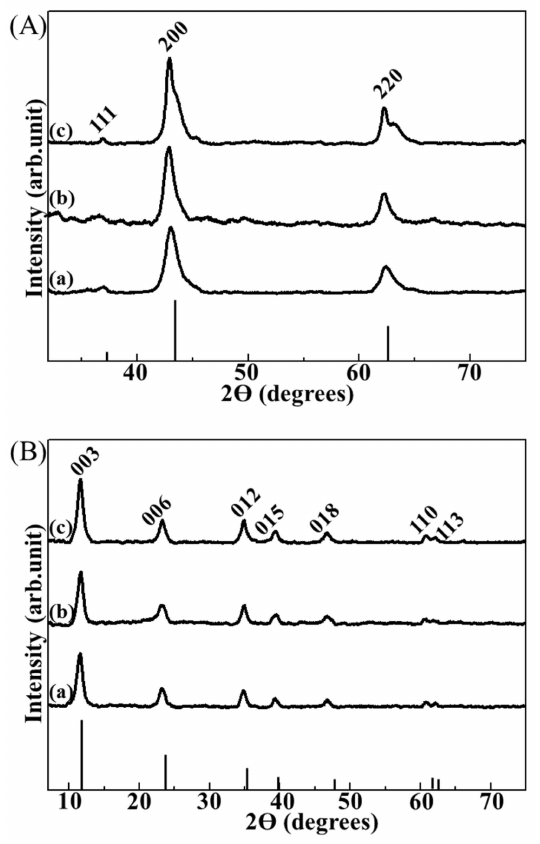
Figure 2. X-ray diffraction (XRD) patterns of ( A ) calcined composites and ( B ) reconstructed ones for ( a ) LDH-agarose composite hydrogel (0.5 wt/v% agarose concentration, C-0.5), ( b ) LDH-agarose composite hydrogel (1 wt/v% agarose concentration, C-1) and ( c ) LDH-agarose composite hydrogel (2 wt/v% agarose concentration, C-2), respectively. XRD patterns of the calcined composite ( A ) showed a typical phase of periclase (JCPDS No. 71-1176), and those of reconstructed ones ( B ) exhibited the layered double hydroxide (LDH) phase (hydrotalcite, JCPDS No. 14-0191). The vertical lines under the XRD patterns are the corresponding JCPDS